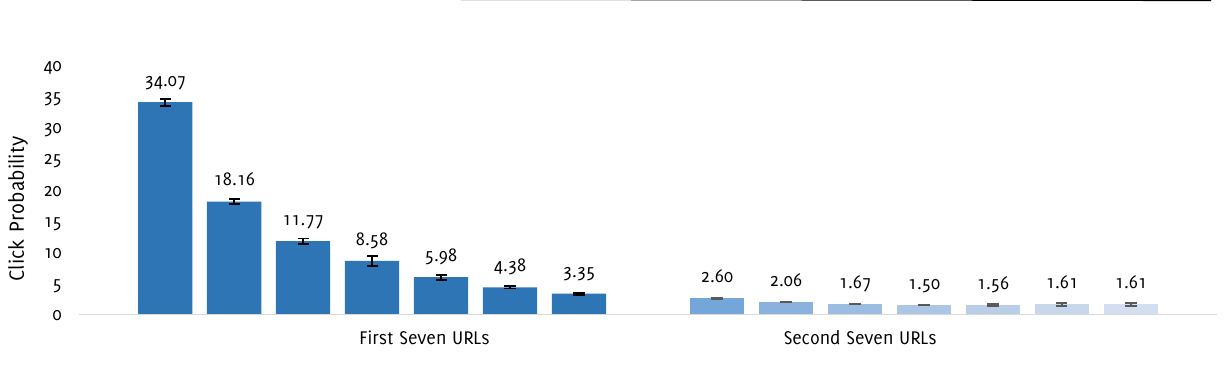
marginal at 63 for “cervical cancer” and 57 for “pap smear”. Considering that Google uses location as one of the determining factors